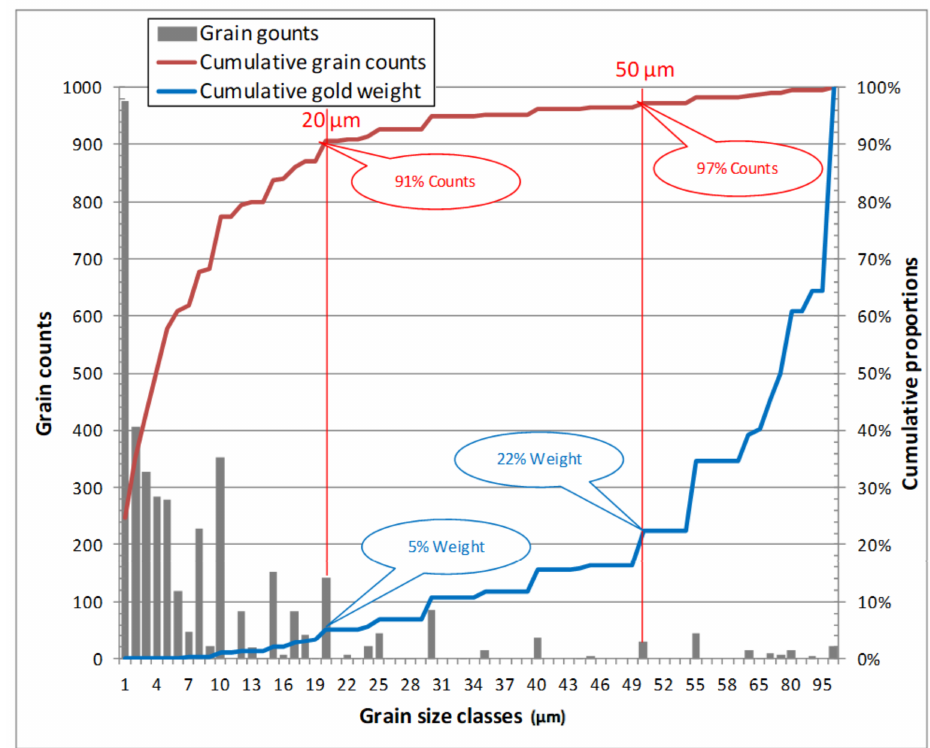
Figure 1. In-situ gold grain size distribution in rocks from the Archean syn-orogenic gold deposits of the Superior Craton, Northwestern Qu é bec, and Northeastern Ontario, Canada. Measurements on 3934 gold grains smaller than 100 µ m were conducted over a 20-year period by the same mineralogist (Mme Lucie Tremblay) from hundreds of polished thin sections using a reflected light petrographic microscope. Grain counts are indicated by grey bars on the right scale, while the cumulative distribution is indicated by the red curve on the right scale. The blue curve represents the cumulative proportion of gold weight calculated from the grain size, assuming a spherical shape. While the grain counts are overwhelmingly dominated by small grains, the bulk of the gold weight is constituted by large grains, which explains the good metallurgical recovery, despite the poor grain recovery of most gravimetric concentration methods. The references at 20 and 50 µ m are indicated. It should be noted that the size scale is skewed for large grains, and grains larger than 100 µ m were excluded from the cumulative